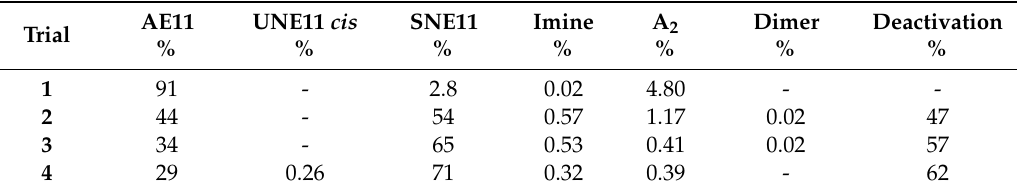
Table 7. 1 : First cycle hydrogenation of UNE11. 2 : hydrogenation of UNE11 with catalyst from 1 recovered and washed with 3 × MeOH and 3 × toluene. 3 : hydrogenation of UNE11 with the catalyst (from trial 2) reactivated in MeOH solution under 120 kHz, 100 W input power. 4 : hydrogenation of UNE11 with the catalyst (from trial 2) reactivated in MeOH solution under 120 kHz, 200 W input power. AE11 : methyl-11-aminoundecanoate, UNE11 : (9 Z )-10-cyano-9-decenoate, SNE11